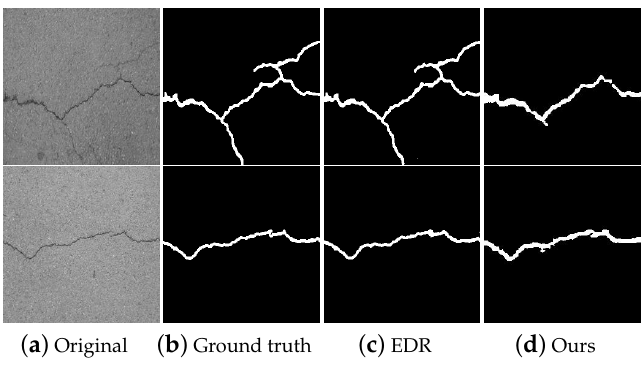
Figure 7. The outputs of EDR method and ours on CrackForest dataset.